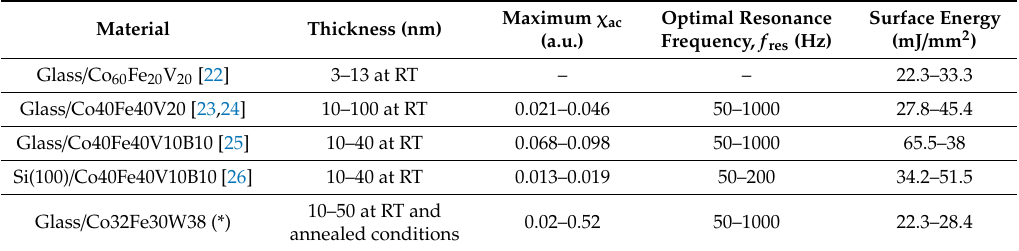
Table 1. Specific properties for various CoFeV, CoFeVB, and CoFeW